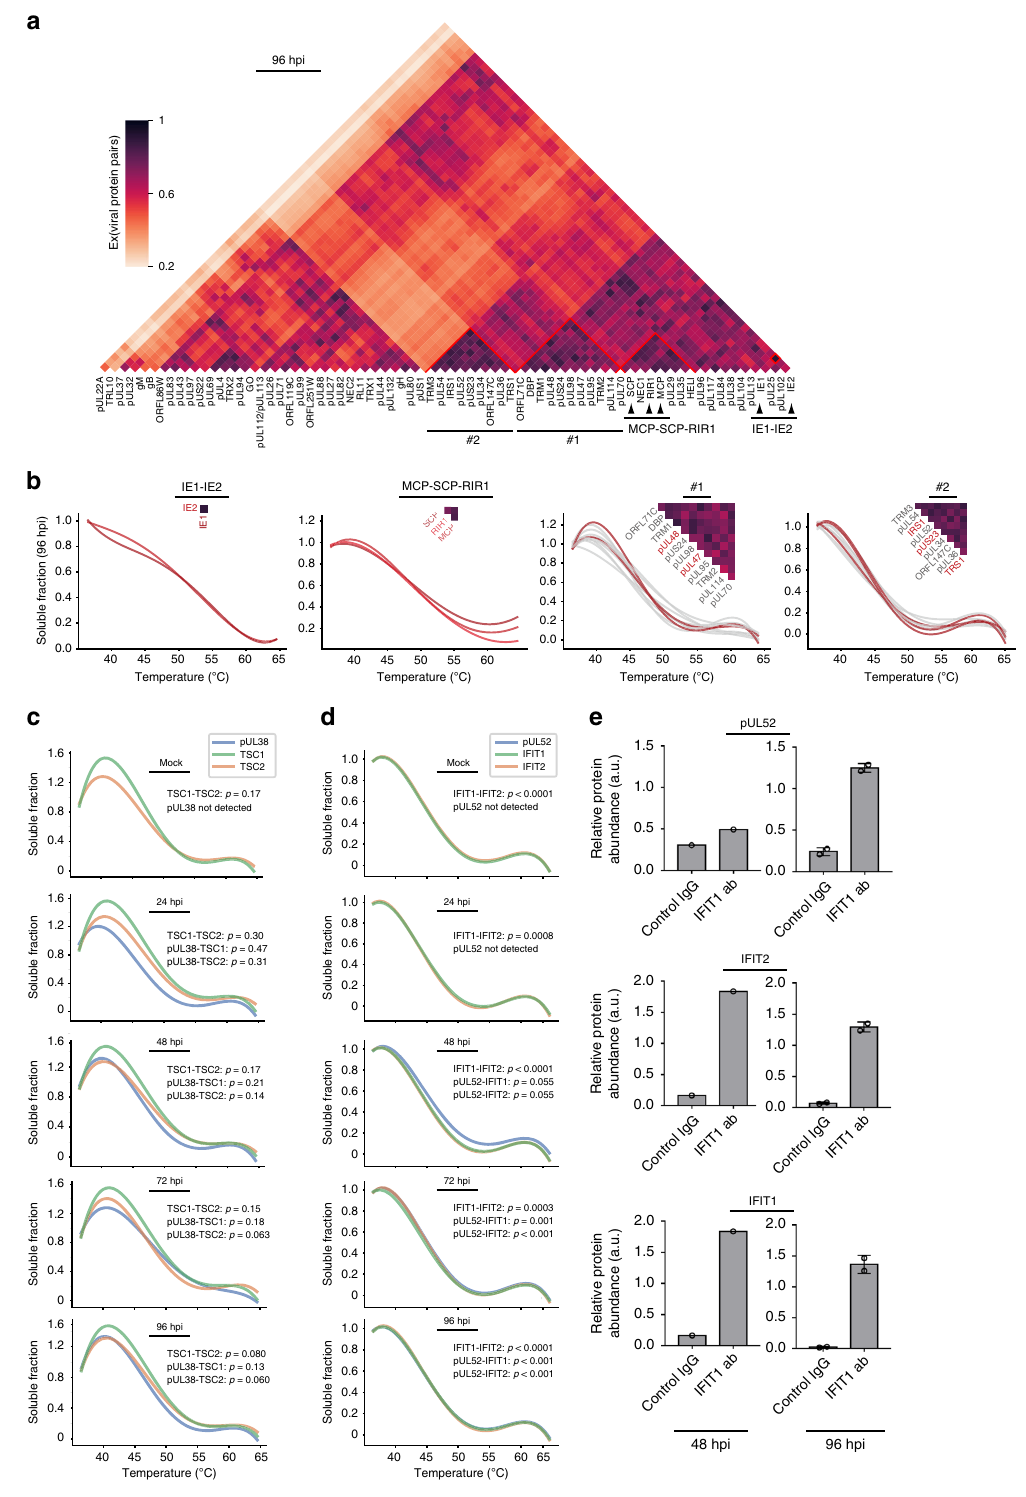
Fig. 8 Thermal pro fi ling points to virus – virus and virus – host protein interactions, including the association of the essential HCMV pUL52 with immunomodulatory host proteins. a Distance matrix of Ex for pairs of quanti fi ed viral proteins. Color indicates Ex value for the corresponding protein pair. Clusters #1 and 2 highlight potential viral complexes. b Coaggregation curves of IE1 and IE2 (left), MCP, SCP, and RIR1 (left middle), proteins in cluster #1 (right middle) and proteins in cluster #2 (right) at 96 hpi. Known and literature-suggested complex components are indicated in red. c , d Coaggregation curves of c pUL38- TSC1-TSC2 and d pUL52-IFIT1- IFIT2 at each infection time point. pUL52 was not detected at mock and 24 hpi. Statistical analysis of curve similarities is shown with p -values (corrected with Benjamini-Hochberg procedure generated using random protein pair sampling). e IP-PRM analysis validating the complex composed of pUL52, IFIT1, and IFIT2. An anti-IFIT1 IP or a control IgG IP was conducted at 48 and 96 hpi and abundances of pUL52, IFIT1, and IFIT2 were quanti fi ed by PRM. Data represent average normalized abundance ± SD, n = 1 for 48 hpi, and n = 2 for 96